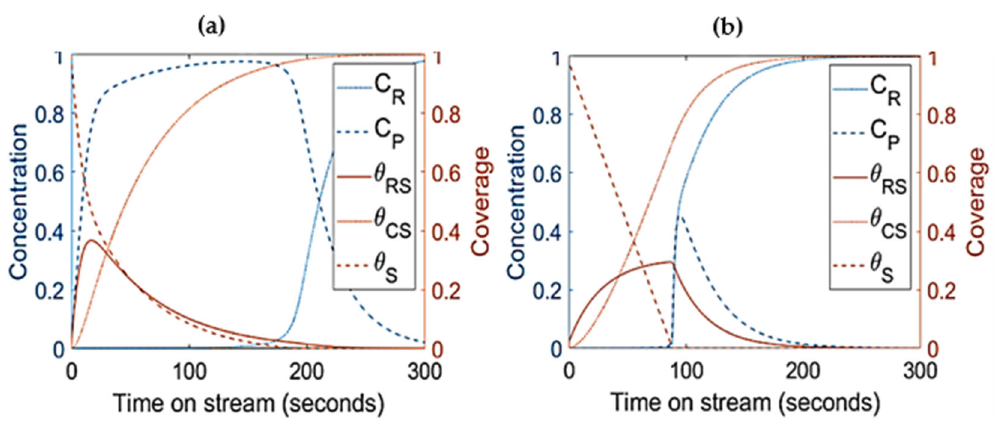
Figure 6. Estimated reactant and product concentration pro fi les ( left axis ) and surface species cov- erages ( right axis ) with respect to time: sensitivity analysis for Mechanism II, ( a ) with increased 𝑘 (cid:2870) by 100% and ( b ) decreased 𝑘 (cid:2879)(cid:2870) by 10% ( b ) 𝜏 (cid:3404) 5 s.